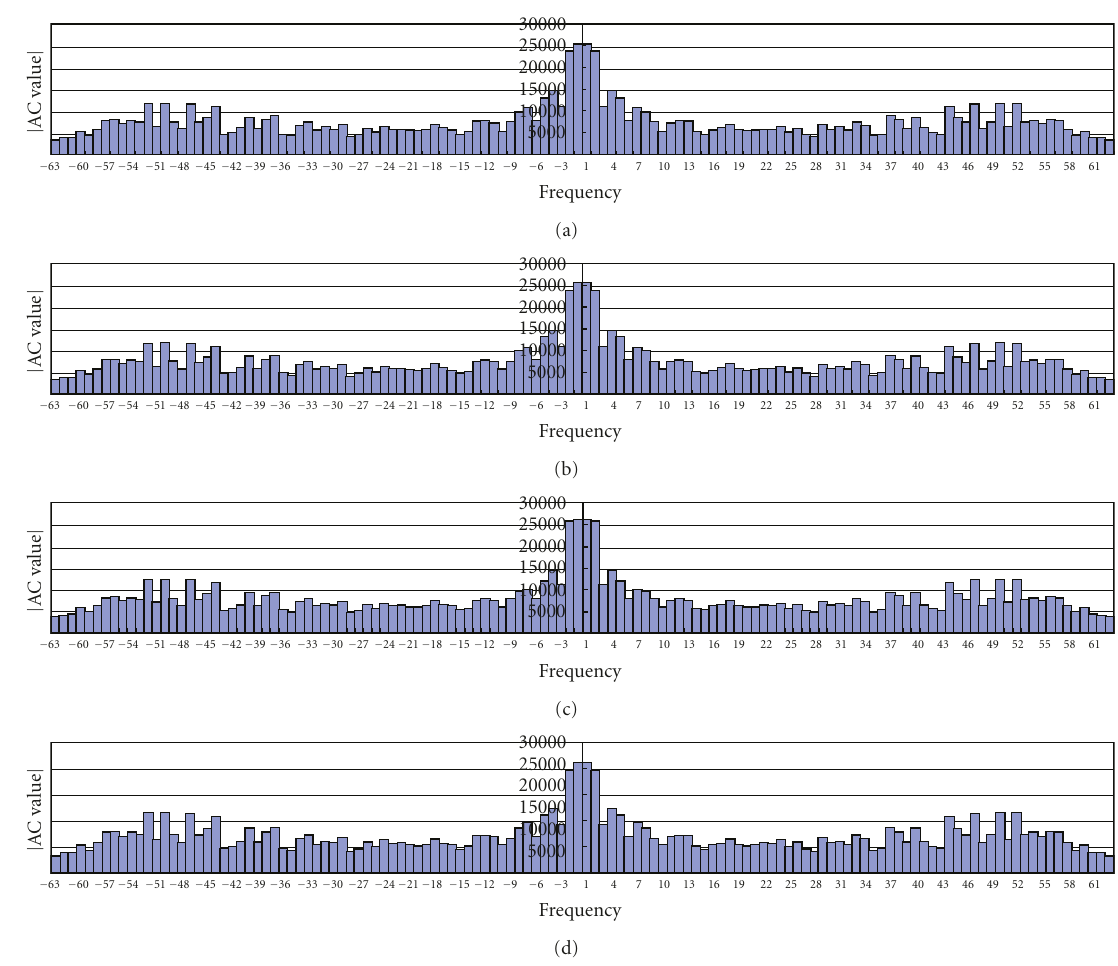
Figure 6: (a) Spatial-frequency distribution converting into one dimensionfor G1 component. (b) Spatial-frequency distribution converting into one dimension for G2 component. (c) Spatial-frequency distribution converting into one dimension for R component. (d) Spatial- frequency distribution converting into one dimension for B component.